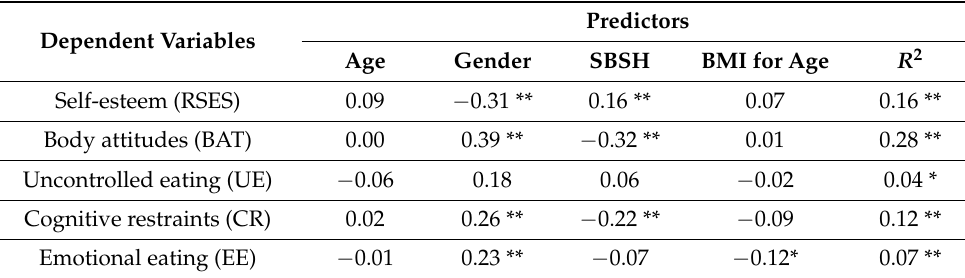
Table 2. Results of the regression analysis: standardized β and R 2 values. (SBSH: Subjective body shape). * p < 0.05, ** p <